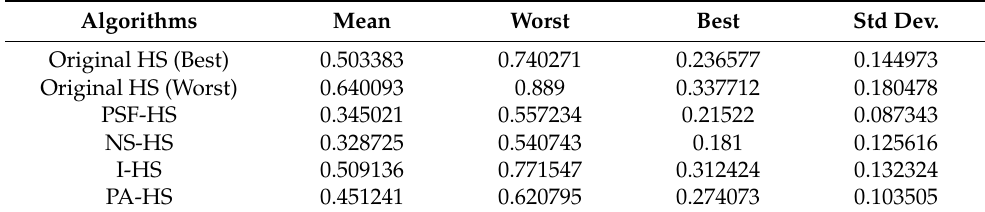
Figure 7. Comparative experimental results for original HS and adaptive HS. Table 4. Comparative experimental results for HS and adaptive HS.